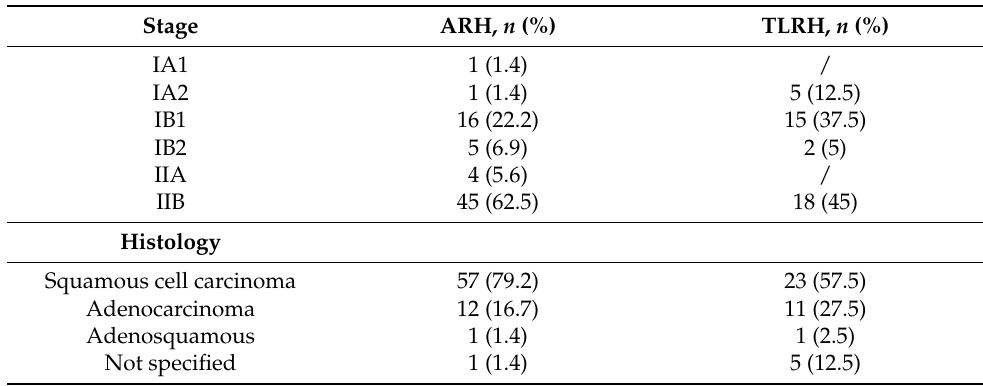
Table 3. Stage, histology and grade of the cervical cancer in women who underwent abdominal radical hysterectomy (ARH) and total laparoscopic radical hysterectomy (TLRH).